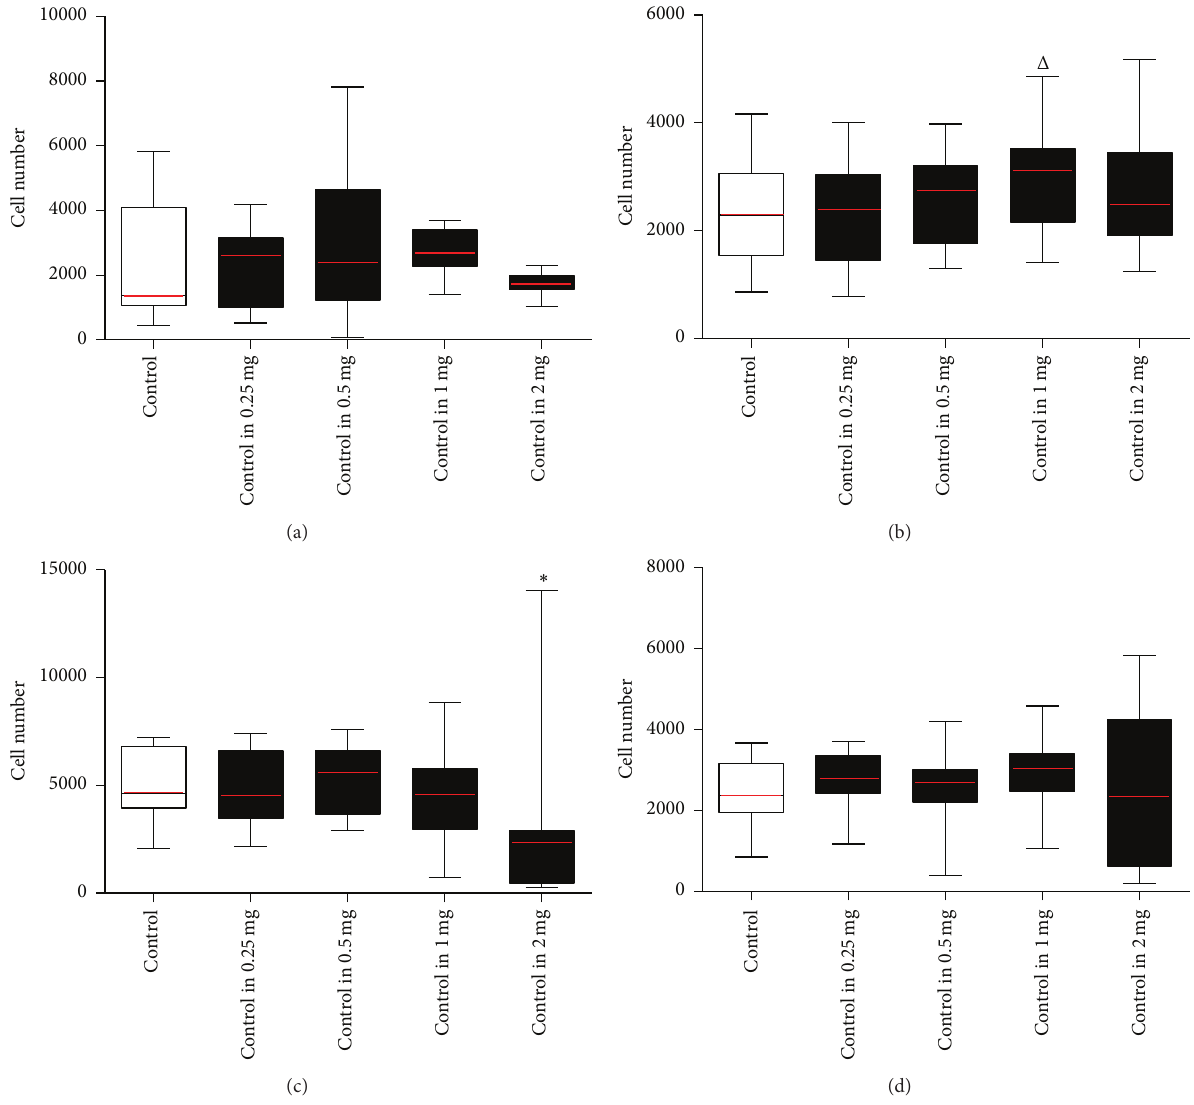
Figure 1: MSCs grown in control media and seeded in HA media. MSCs expanded until passage 2 in control media. Cells from flask (A) were then stripped and cell suspensions were counted using the standard enumeration technique. Cells were seeded into 96-well plates in either control media (control) ( − − ) or HA media ( − +) containing a series of concentrations ranging from 0.25 to 2mg/mL of HA to make up the five conditions ( 𝑥 -axis). Conditions were tested using five technical replicates per 96-well plate and run in biological triplicate ( 𝑛 = 3 ). Wells were assayed at the endpoint using Cell Counting Kit-8 with standard curves run on every 96-well plate seeded 24 hours prior to endpoint and absorbance read at a wavelength of 450 nm ( 𝑦 -axis). All conditions were compared back to the control using a 𝑡 -test ( Δ 𝑝 value = 0.07, ∗ 𝑝 value < 0.05). (a) MSCs seeded in standard 96-well plates for 24 hours (adherence), (b) MSCs seeded in standard 96-well plates for three days (proliferation), (c) MSCs seeded in high -adherence 96-well plates for 24 hours (adherence), and (d) MSCs seeded in high -adherence 96-well plates for three days (proliferation) (see Supplementary Table